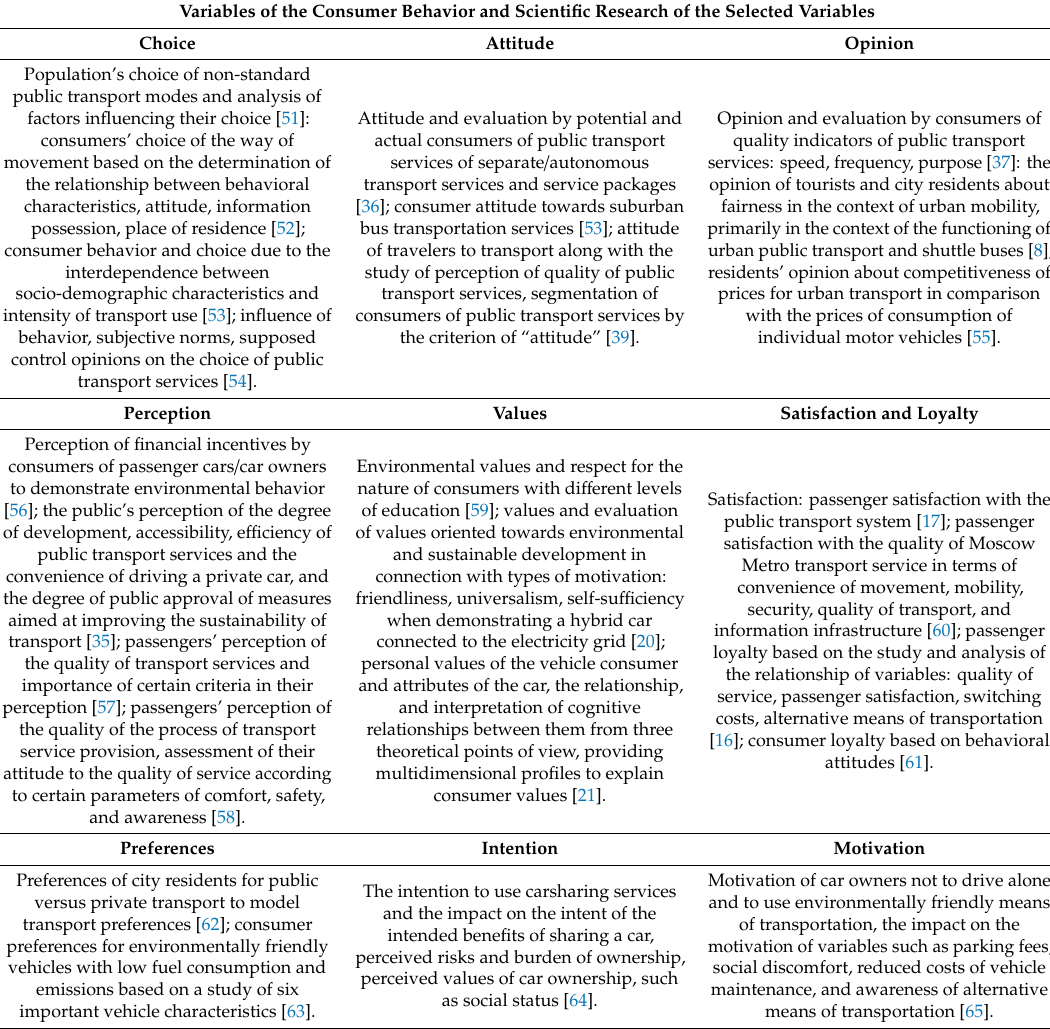
Table 1. Variable behavior of potential and actual consumers of public transport